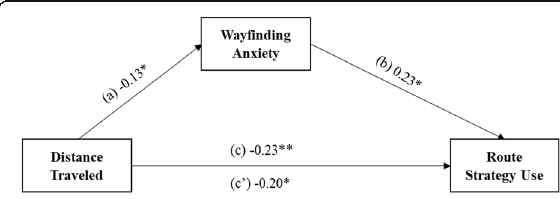
Fig. 8 Direct and indirect effects of distance traveled on wayfinding anxiety through the mediator route strategy, controlling for participant sex and trait anxiety. * p < .05, ** p < .01, *** p < .001